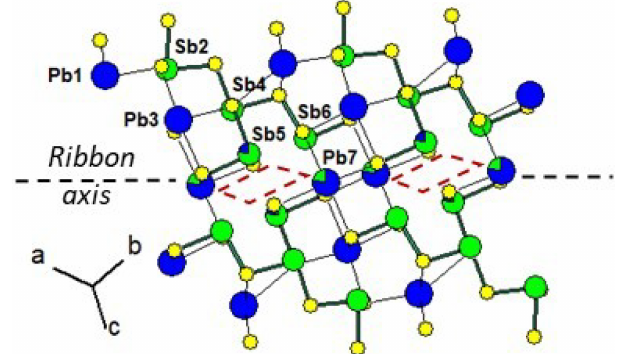
Figure 5. Mixed Pb / Sb sites in the ribbon of the structure of pla- gionite from Monte Arsiccio (sample P1). Red lozenge: neighbour- ing (Sb,Pb)5 ( × 2) and (Pb,Sb)7 ( × 2) mixed sites. For clarity, mixed sites are unsplit.